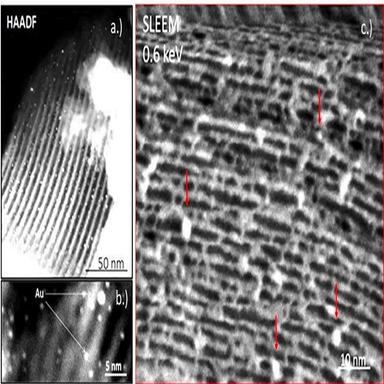
(a.) and b.)) Traditional HR STEM images obtained with 30 keV versus (c.) an ultra-high resolution image obtained with SLEEM with 0.6 keV electron beam combined with deep learning method for Au nanoparticles-loaded SBA-15 meso‑porous silica are compared.